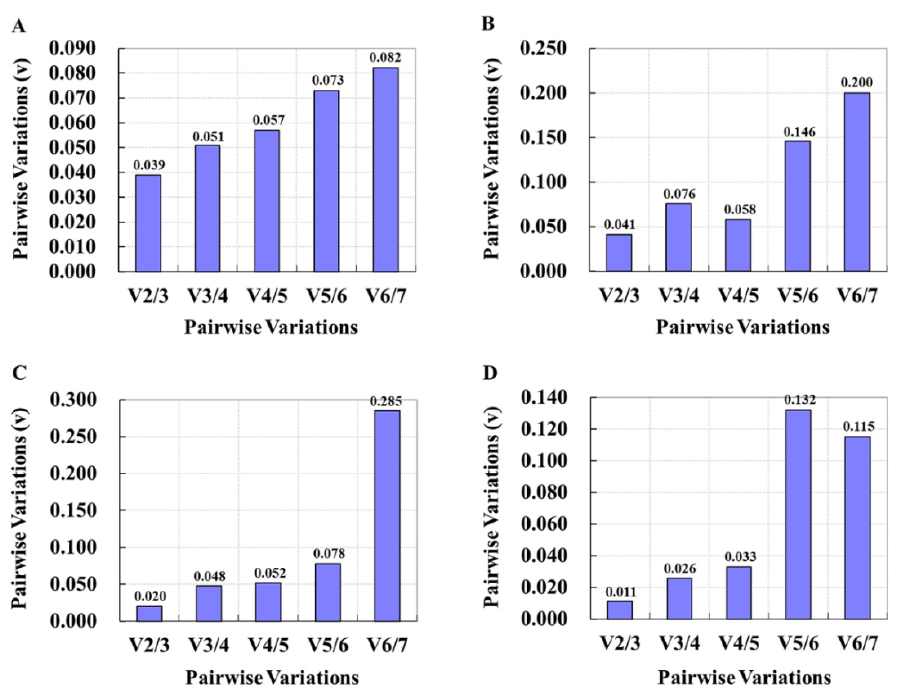
Figure 10. Optimum pairs of housekeeping gene candidates necessitated for normalization in GPHK cells under stimulation with Poly I:C for 2 ( A ), 4 ( B ), 8 ( C ) and 12 h ( D ) according to geNorm analysis. The optimal number of reference genes depends on the V n/n+1 value via geNorm analysis; moreover, the value is popularly less than 0.15.